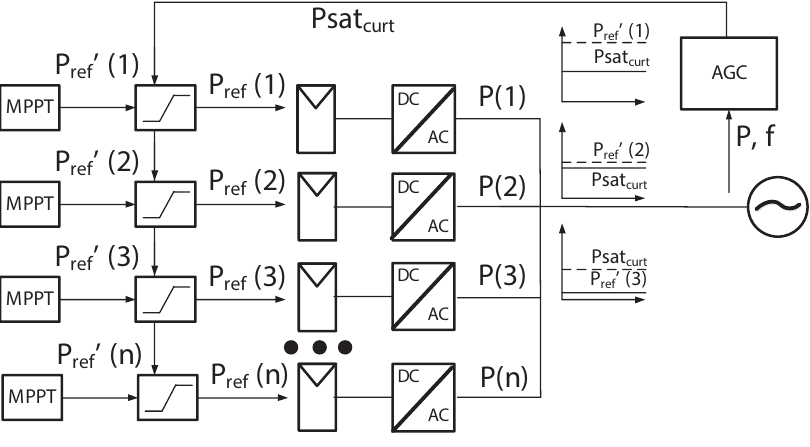
Figure 4. Power system resident FR by an AGC. A common control curtailment signal ( P sat to all inverters.